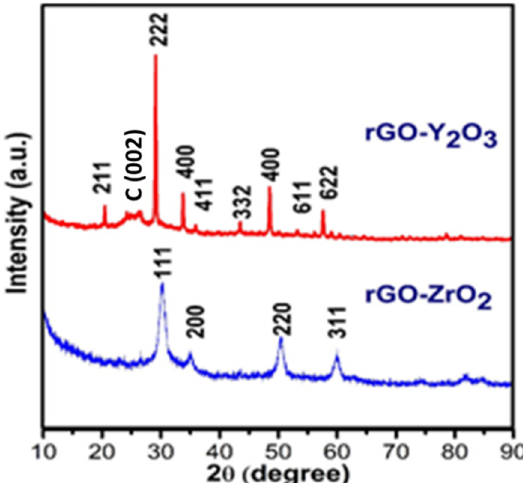
Figure 1. XRD pattern of rGO-ZrO 2 and rGO-Y 2 O 3 nanocomposites. SEM micrographs obtained for rGO-ZrO 2 and rGO-Y 2 O 3 nanocomposite are